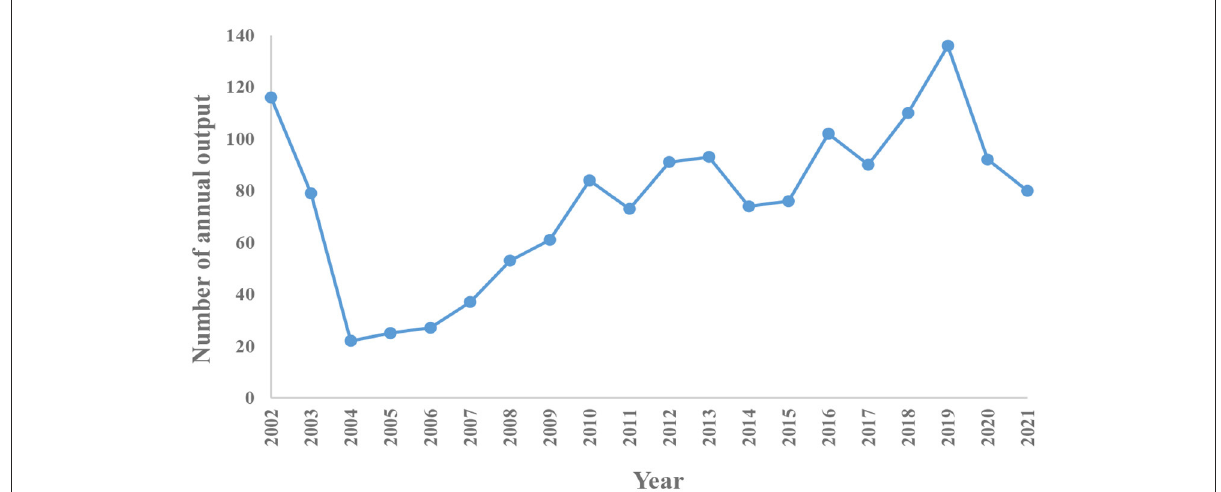
FIGURE2 The annual number of publications and trends on MSCs in orthopedics between 2002 and 2021.